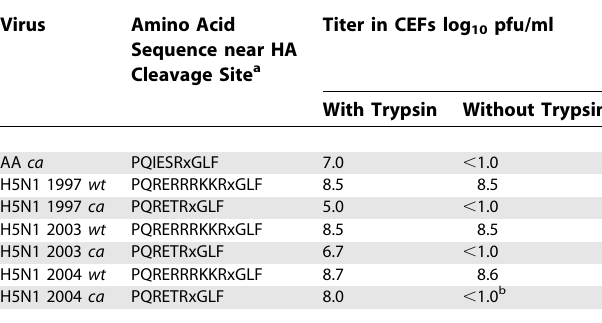
Table 1. H5N1 ca Viruses without the Multibasic Amino Acid Motif in the HA Require Trypsin for Plaque Formation in CEFs Virus Amino Acid Sequence near HA